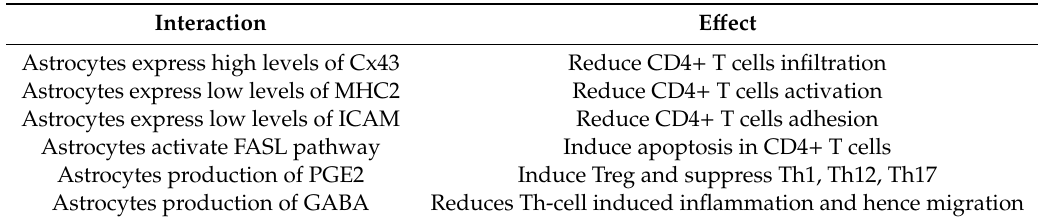
Table 4. Mechanism of action with which Astrocytes hinder CD4 + T cell migration in homeostasis.